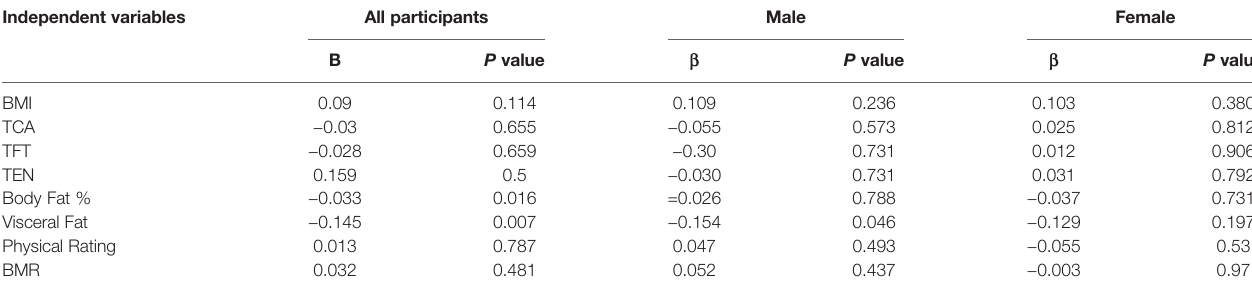
TABLE 4 | Multiple regression analysis of BQI determinants. Independent